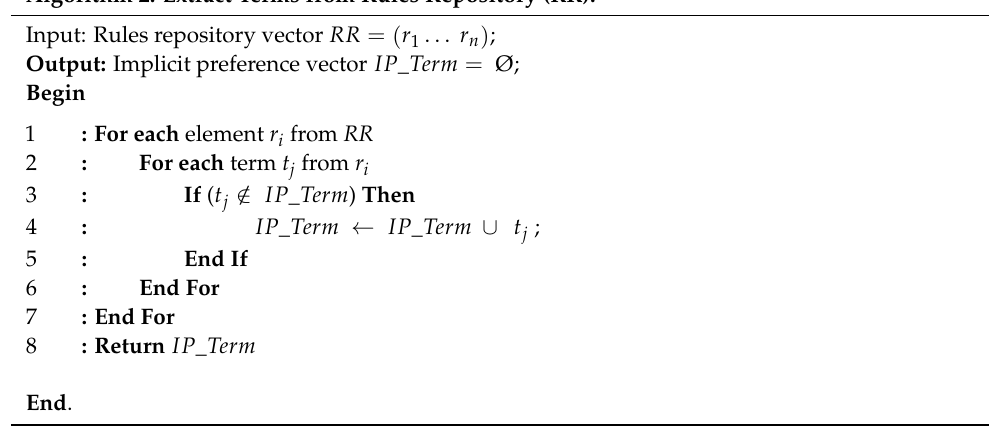
Algorithm 2: Extract Terms from Rules Repository